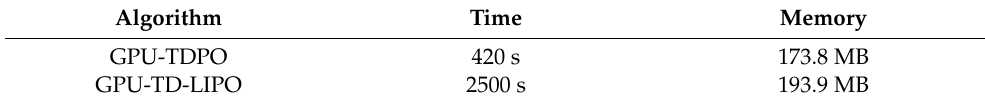
Figure 19. Normalized ISAR images of the aircraft under different methods. ( a ) TDPO; ( b ) TD − LIPO. Table 4. Time and memory of each method.